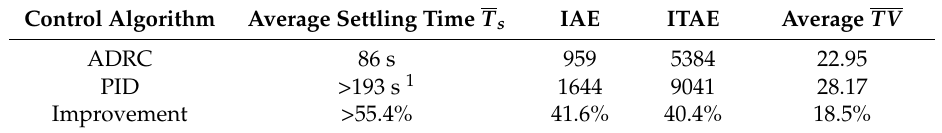
Figure 15. Reference step test results of the PID in the CFB unit (time span of test: 1 September 2017, 9:55:30–10:15:30). Table 4. Control performance comparison of ADRC and PID in the secondary air control system of a 330 MWe in-service CFB unit